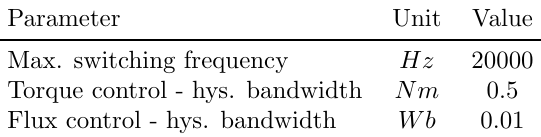
Table 7: C-DTC specific